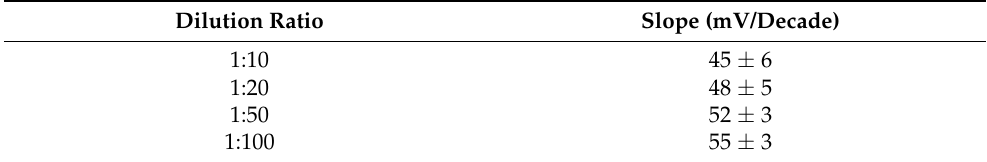
Table 8. Lithium detection in contaminated soils at different dilutions. Each measurement was repeated at least 5 times with the commercial